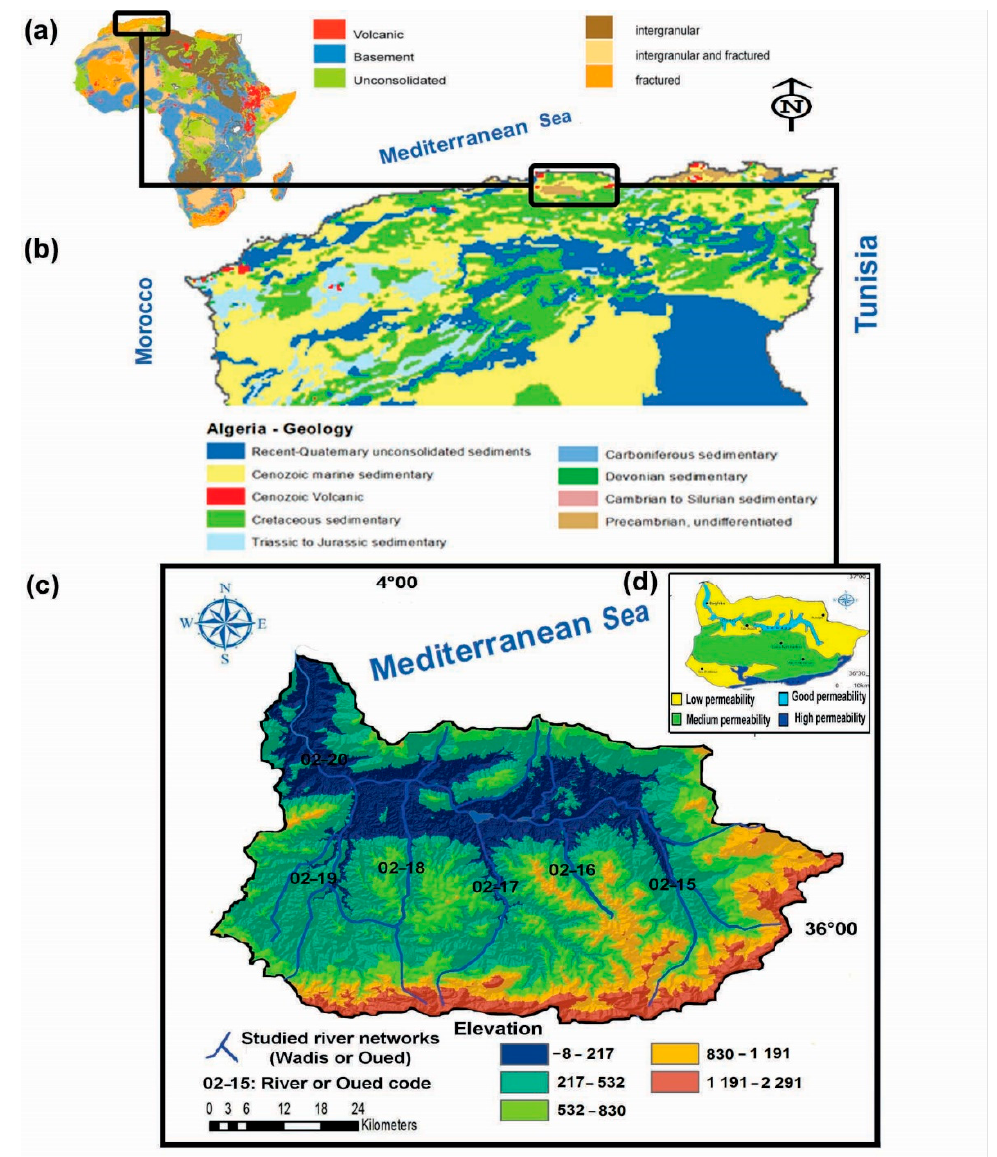
Figure 1. An overview of ( a ) hydrogeology of Africa, ( b ) geology of northern Algeria obtained from United States Geological Survey [49], ( c ) digital elevation model (DEM), and ( d ) permeability map of the study basin according to Flandrin (1952) [50] and modify by Djemai (2008) [51].